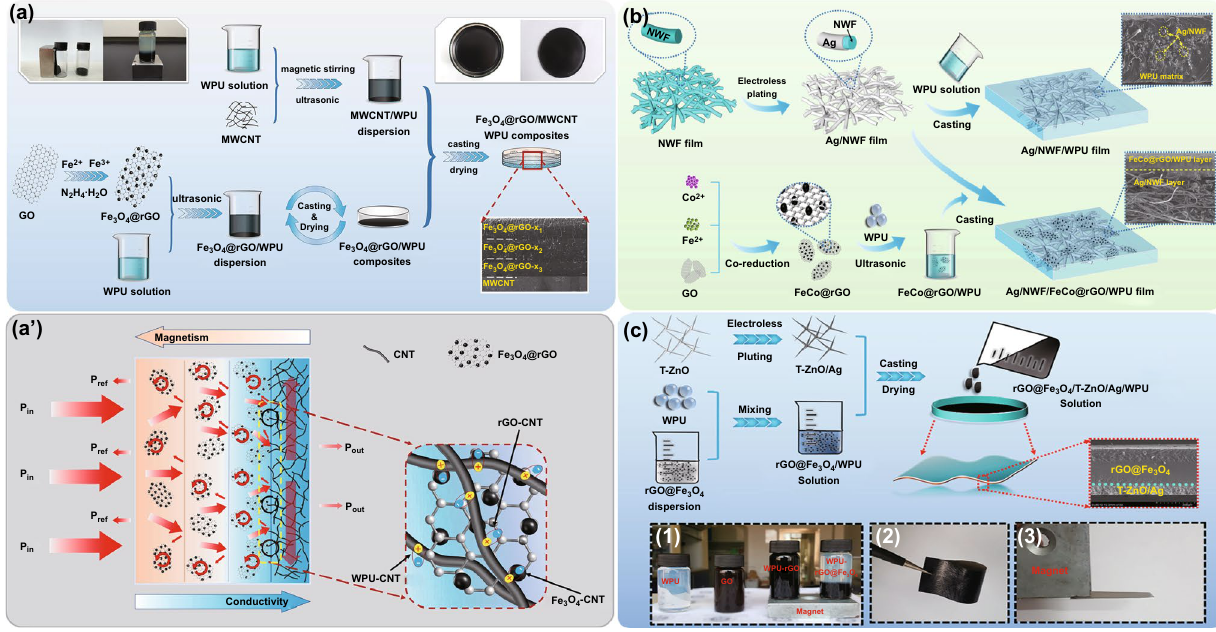
Fig. 12 Schematic illustrating the fabrication of a Fe 3 O 4 @rGO/MWCNTs/WPU, b CNF@MXene, and c Ti 3 C 2 T x /c-PANI composite films [40, 130, 131]. Copyright © 2019 Elsevier. Copyright © 2020 Elsevier. Copyright © 2018 American Chemical